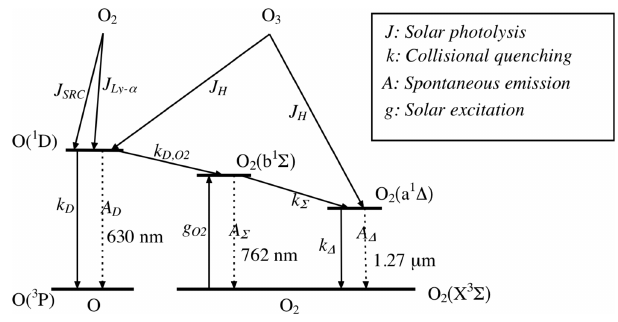
Figure 9. Energy diagram of the O and O 2 molecules showing both O 2 bands at 762nm (A) and 1.27µm. Only the O 2 photo- dissociation ( J SRC (Schumann–Runge continuum) and J Ly − α ) is not taken into account in our model, since this represents only about 1% of the integrated emission (reproduced from Wiensz,